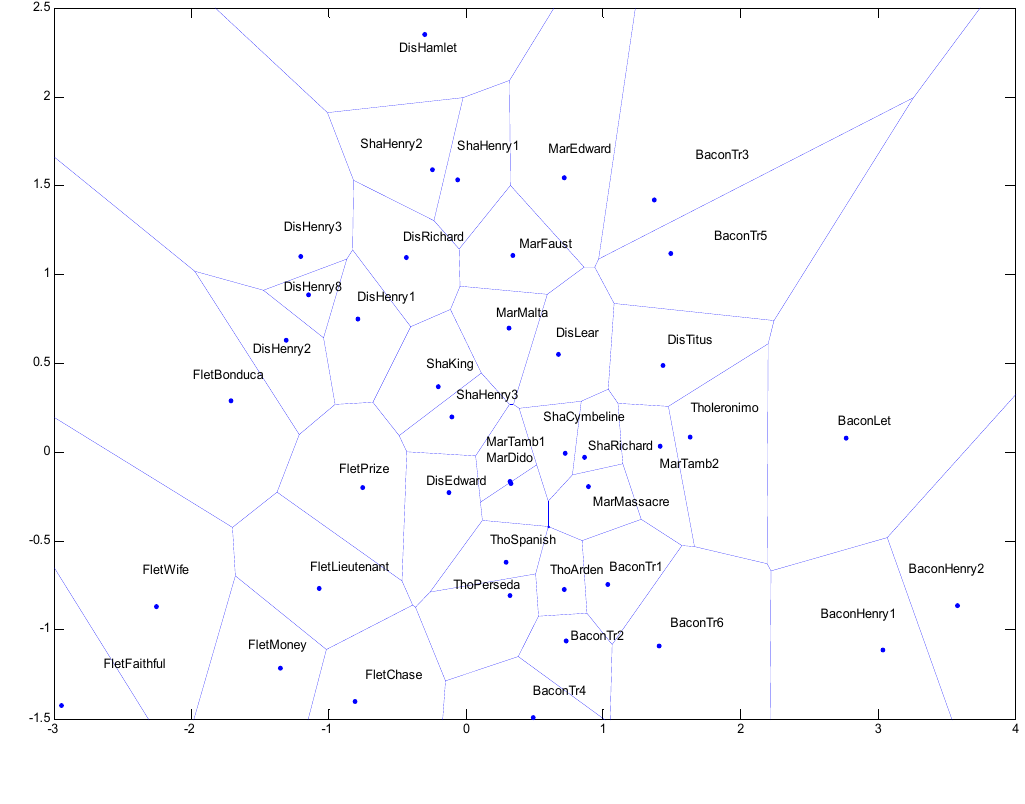
Figure 24. Voronoi map of D trigram